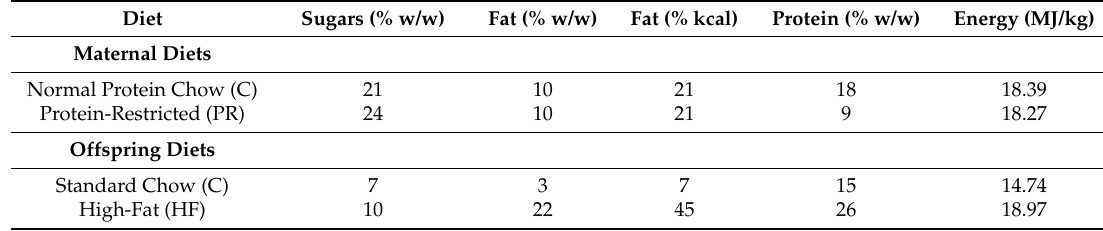
Table 1. Nutritional composition of diets